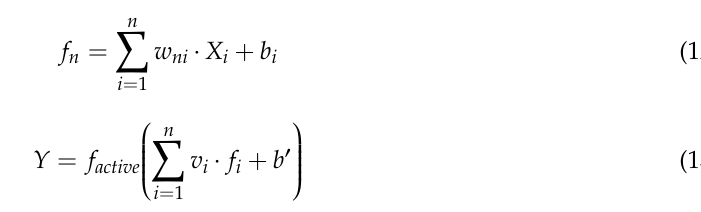
Figure 6. The single-axis RINS installed on the turntable. The thermal chamber is set at seven temperature points as shown in Table 3. The single-axis RINS maintains thermal insulation for 3 h before the cold start; when the temperature field is stable, the single-axis RINS is turned on without the torque motor rotation at each temperature point. The IMU raw outputs are collected and used to calibrate the IMU biases caused by temperature based on those three methods. 5.1.1. The Thermal Calibration Experiments Based on Method 1 In method 1, the thermal model is a piecewise function: (